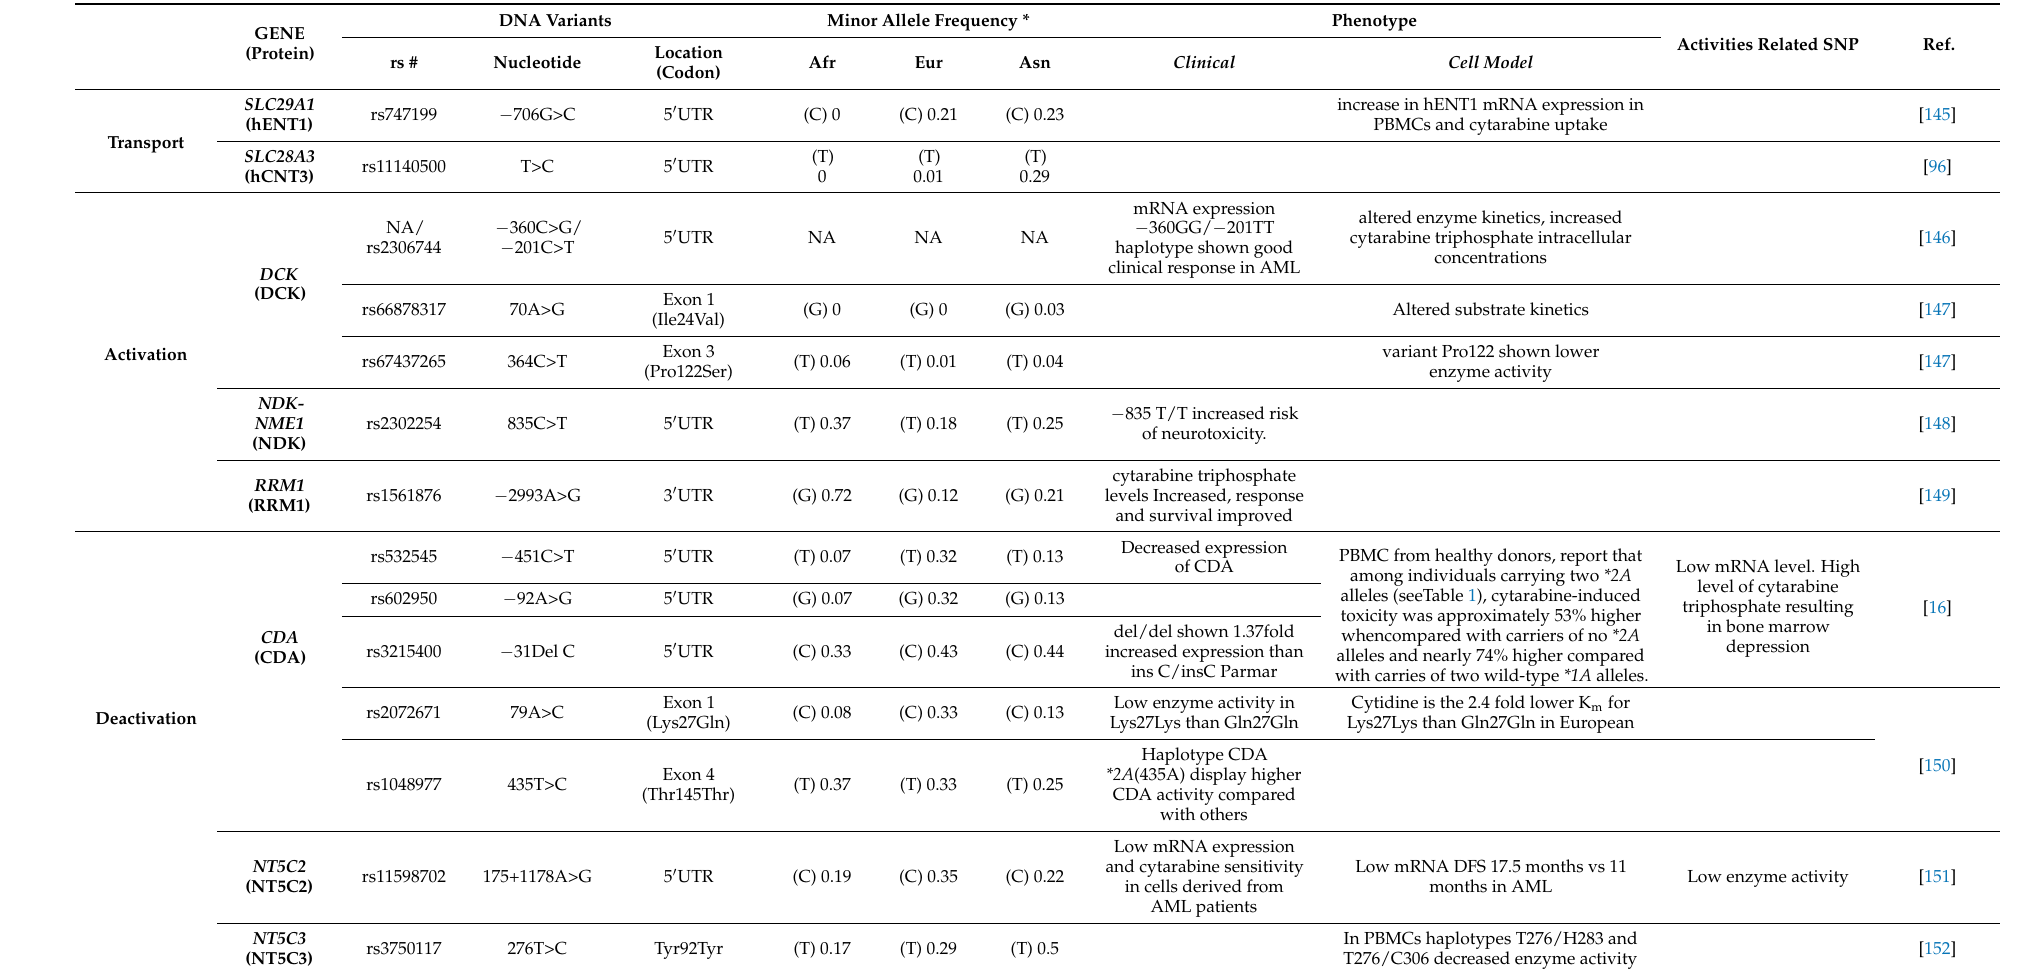
Table 5. Overview of gene variants that may affect response to